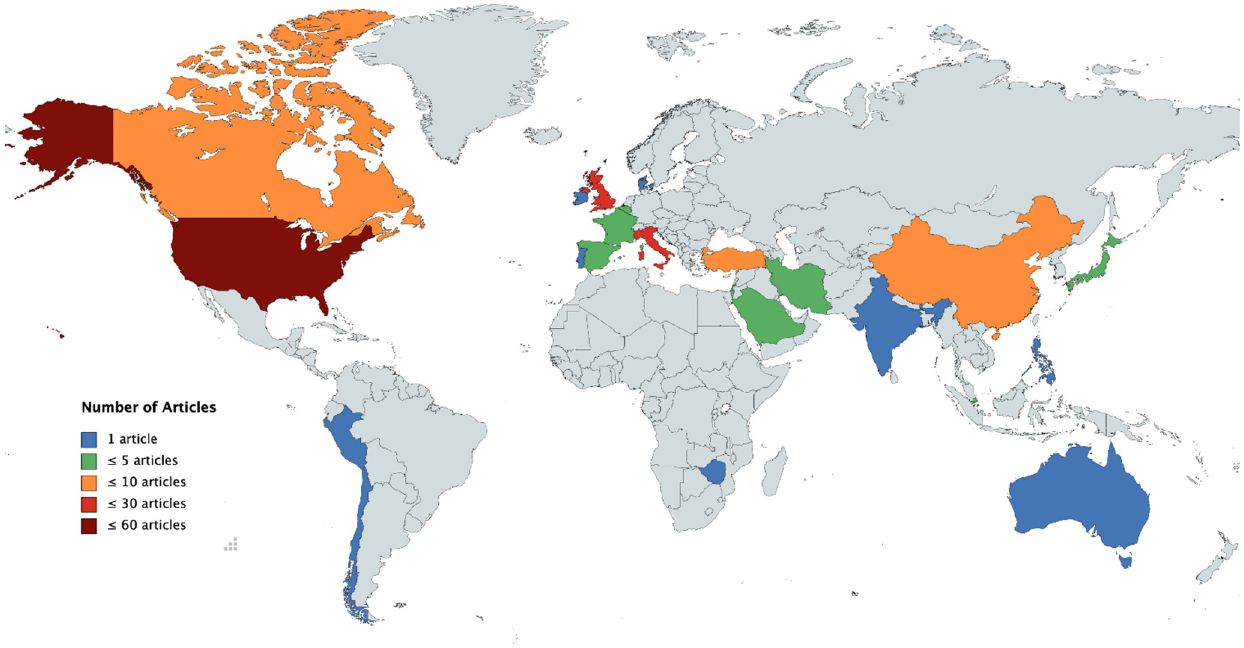
Figure 1. Countries of origin of the 142 papers included in our literature review, color-coded by the number of contributions on a World Map (https://mapchart.net/world.html, free online tool, accessed on 9 April 2022). In detail, contributions came from 23 countries, with information per country on the total number of papers (in brackets separate counts for quantitative studies / qualitative studies / topical reviews, editorials, or opinion papers): Australia ( N = 1: 1/0/0), Belgium ( N = 2: 1/1/0), Canada ( N = 7: 2/0/5), Chile ( N = 1: 1/0/0), China ( N = 7: 4/2/1), Denmark ( N = 1: 0/0/1), France ( N = 5: 2/0/3), India ( N = 1: 0/0/1), Iran ( N = 3: 1/0/2), Ireland ( N = 1: 0/1/0), Israel ( N = 2: 1/0/1), Italy ( N = 17: 9/2/5), Japan ( N = 4: 3/0/1), the Philippines ( N = 1: 0/1/0), Portugal ( N = 1: 1/0/0), Saudi Arabia ( N = 3: 3/0/0), Singapore ( N = 2: 0/0/2), Spain ( N = 3: 3/0/0), Turkey ( N = 9: 4/3/2), UK ( N = 19: 6/5/8), USA ( N = 53: 21/4/27), and Zimbabwe ( N = 1: 0/1/0). Note: The map data are for 145 papers, including 3 further papers (one from Peru, one from the USA, and one from Italy) which were excluded from the review despite being topically relevant, either because they were written in a different language, or because we had no access to the full text.